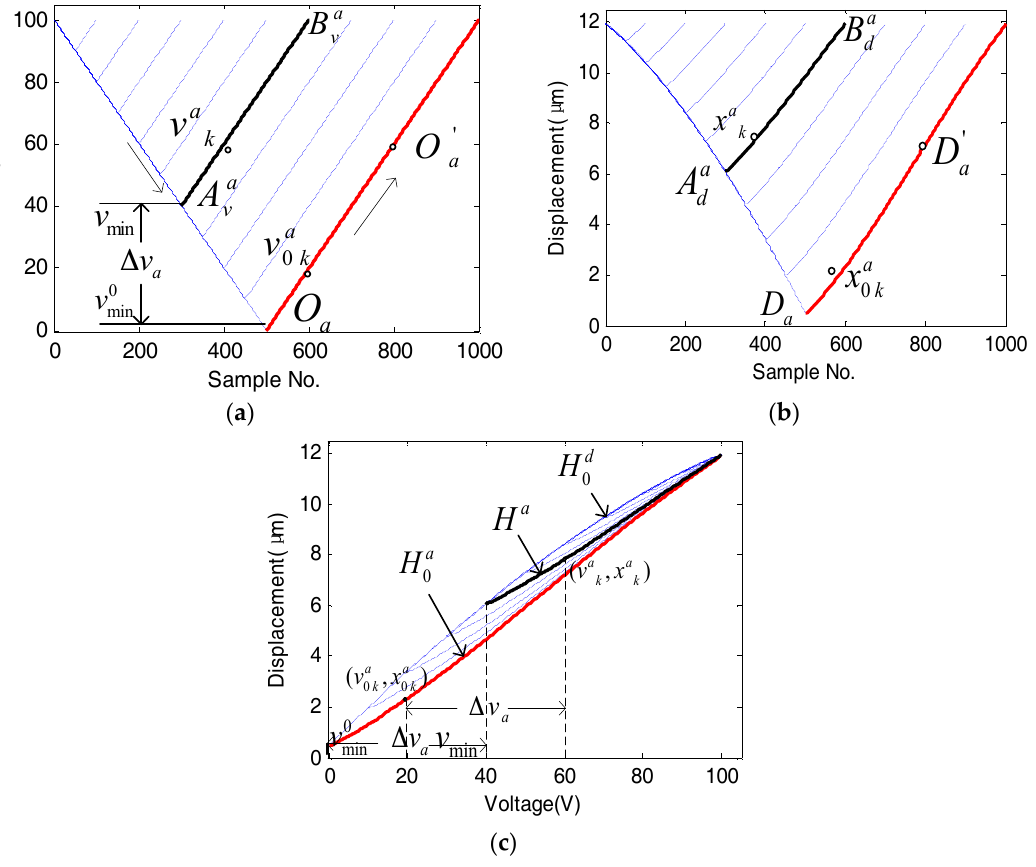
Figure 9. Similarity for ascending hysteresis curves. ( a ) 10 sets of input signals with different minimums; ( b ) the ascending output displacement responses; ( c ) the hysteresis responses. Table 3. The identification of Equation (3). ( (cid:1874) (cid:2923)(cid:2919)(cid:2924)(cid:2868) = 0 V). (cid:2204) (cid:1813)(cid:1809)(cid:1814) (v) (cid:2183) (cid:2778)